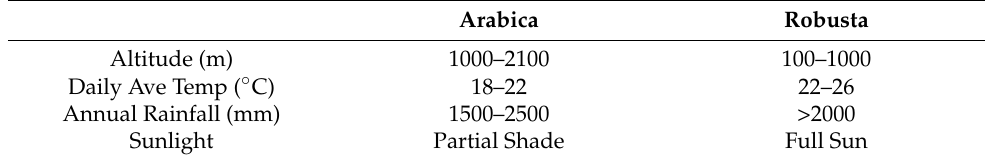
Table 2. Ideal growing conditions for arabica and robusta coffee species